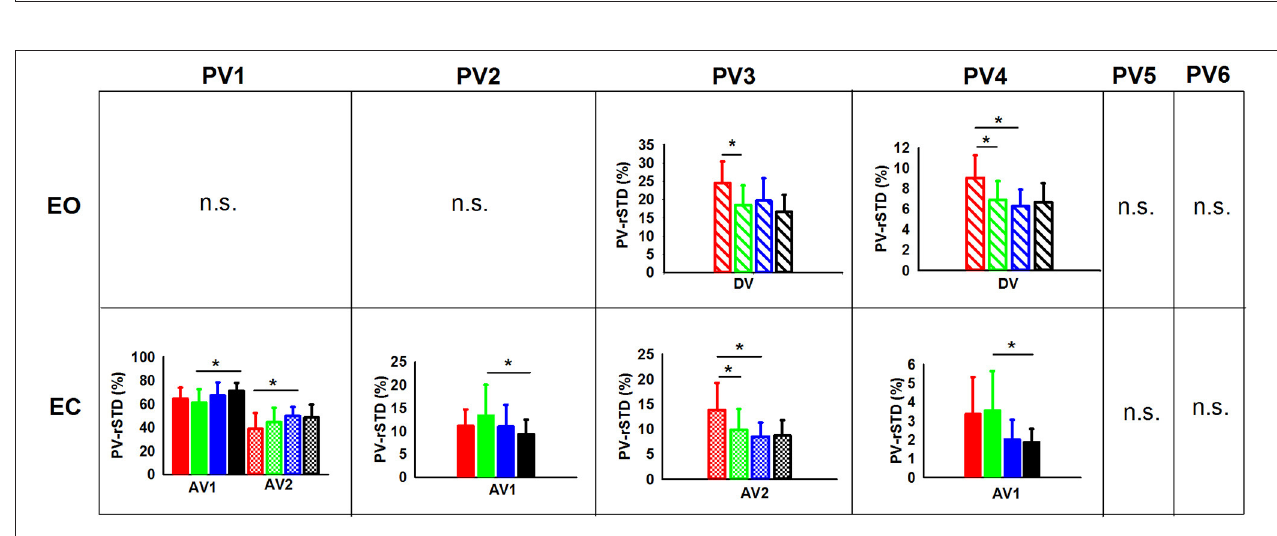
FIGURE 5 | PVs (principal velocities) means and standard deviations for the children [non-gymnasts (C-NG) in red and gymnasts (C-G) in green] and adults [non-gymnasts (A-NG) in blue and gymnasts (A-G) in black] by visual condition (EO, eyes open; EC, eyes closed). Only phases (BV, before vibration; DV, during vibration; AV1, after vibration early phase; AV2, after vibration late phase) with significant differences between groups were plotted (phases were shaded differently). (*) indicates significant differences from planned comparisons. (n.s.) indicates non-significant results.